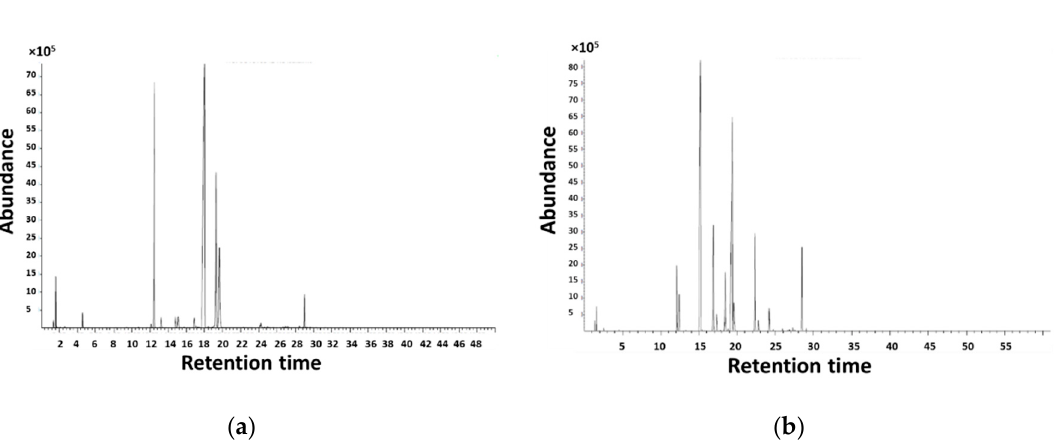
Figure 2. Histogram of the identified volatile compound of aiele and okoume essential oils by GC-MS analysis. The VOC numbers correspond to those used in Table 2.